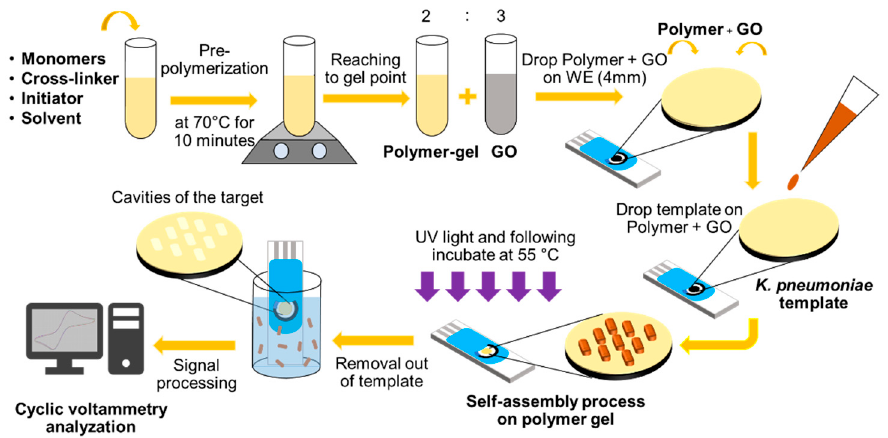
Figure 2. Schematic representation of the preparation of polymer-GO on gold electrode for K. pneu- moniae detection. Table 1. The amount of each functional monomer in various conditions *.